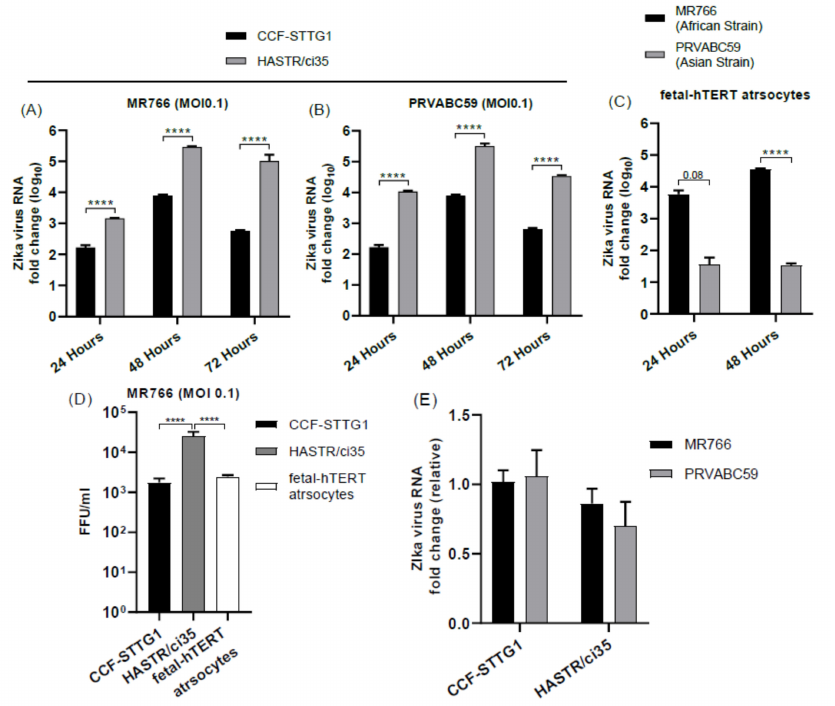
Figure 2. Zika virus load in different astrocyte cell lines. Cells were infected with ZIKV strains MR766 and PRVABC59 at a multiplicity of infection (MOI) of 0.1. ( A – C ) Quantification of Zika virus RNA load in astrocyte cell subtypes using relative quantitative PCR. CCF-STTG1 astrocyte cells presented lowest ZIKV load at all timepoints compared with HASTR/ci35 and foetal-hTERT astrocyte cells. HASTR/ci35 cells showed higher viral RNA load ( A – C ) despite similar level viral entry compared with CCF-STTG1 ( E ). Focus-forming unit (FFU) assay was performed on supernatants collected at 24 h post-infection to assess the infection ability of the virus particles shed by the astrocyte cell lines. HASTR/ci35 astrocytes shed high-level active MR766 virus particles at 24 h compared with CCF-STTG1 and foetal-hTERT astrocytes ( D ). Data were normalised to the 36b housekeeping gene and expressed as a fold change relative to ZIKV RNA load at 6 h timepoints relative to mock-infected control ( A – C ) (data are shown as means ± SEM, n = 3). **** demonstrates significant differences between biological conditions by p <